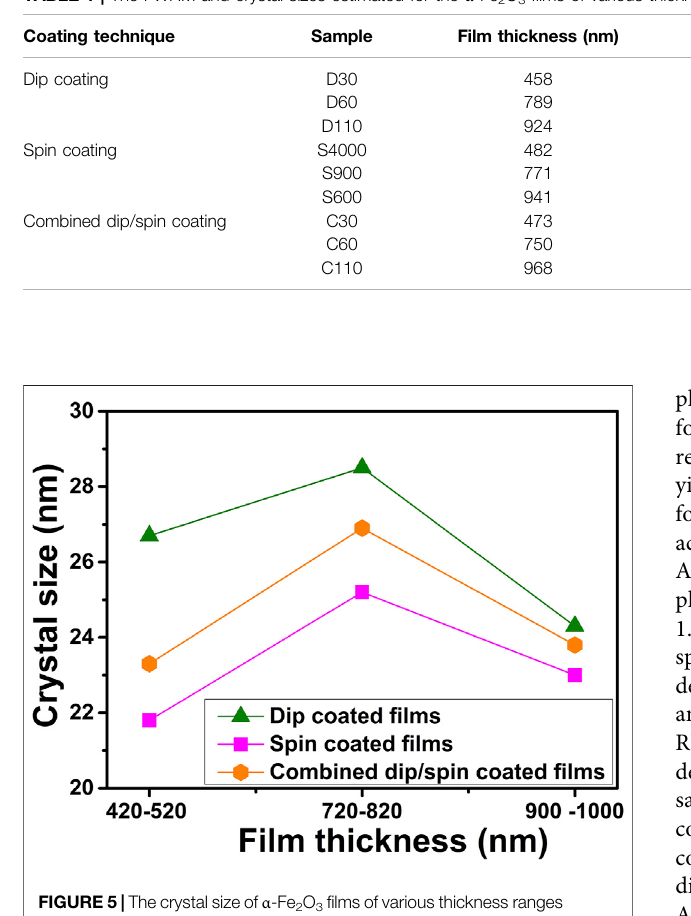
Frontiers in Energy Research |